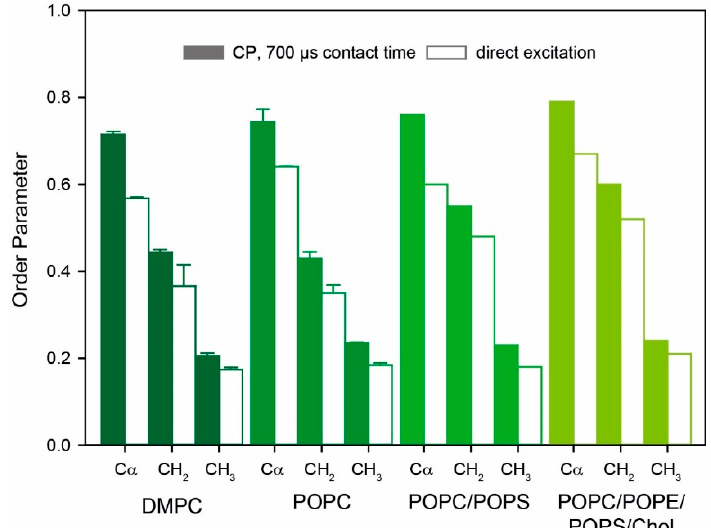
Figure 3. DipShift 1 H- 13 C order parameters of the U- 13 C Y1R in DMPC, POPC, POPC / POPS (8 / 2, mol / mol), and POPC / POPE / POPS / cholesterol (4 / 4 / 1 / 1 mol / mol / mol / mol) membranes detected by either CP excitation with a 700 µ s contact time (filled bars) or direct excitation (open bars). The order parameter for C α , CH 2 , and CH 3 groups are shown. Error bars for measurements in DMPC and POPC were determined from two independent preparations, whereas only single preparations were made for the other membrane systems. Table 1. Molecular order parameters of Y1R reconstituted into DMPC membranes at a temperature of 30 ◦ C in the apo state in the presence of neuropeptide Y (NPY) and in the presence of NPY and coupled to Arr3-3A. C C α CH 2 CH 3